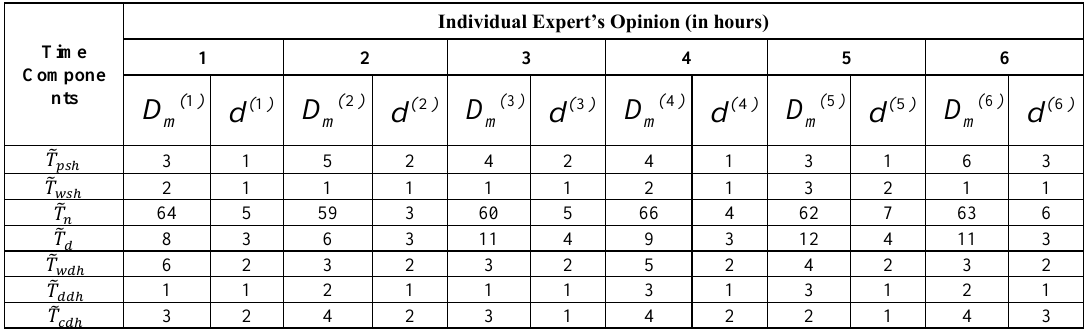
Table 1. Input data set for travel time